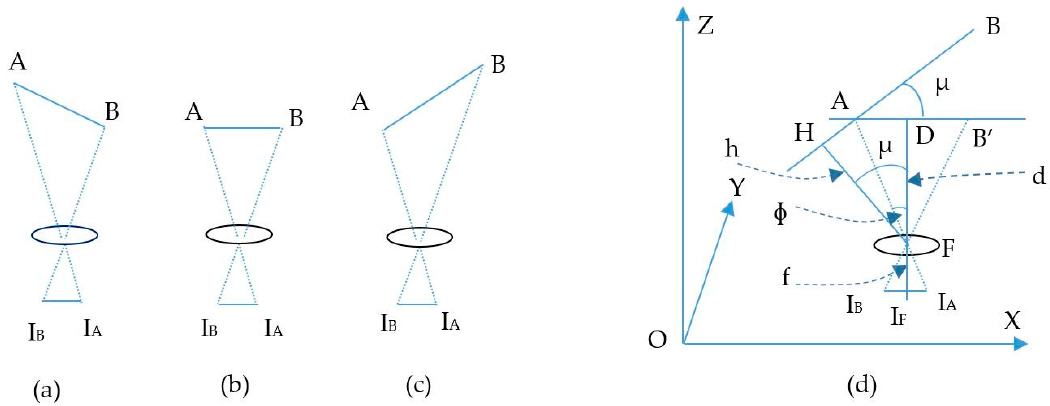
Figure 3. Illustration of different captured angle scenarios. ( a ), ( c ) LEDs line not parallel with image sensor plane. ( b ) LEDs line parallel with image sensor plane. ( d ) Image of LEDs line in image sensor plane.